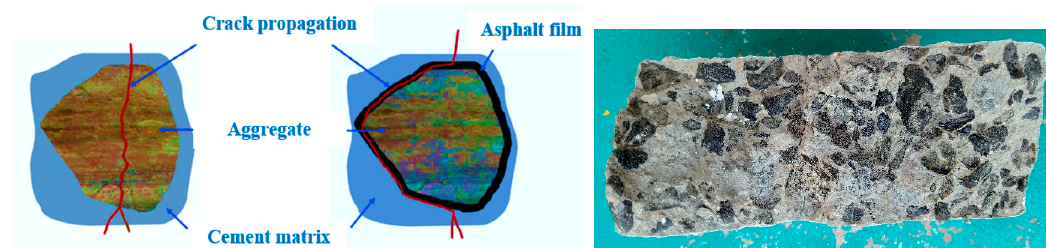
Figure 17. Failure modes of PAFC ( a ) NC, ( b ) NC-C1, ( c ) NC-C2, ( d ) P-PF, ( e ) P-PF-C1, ( f ) P-PF-